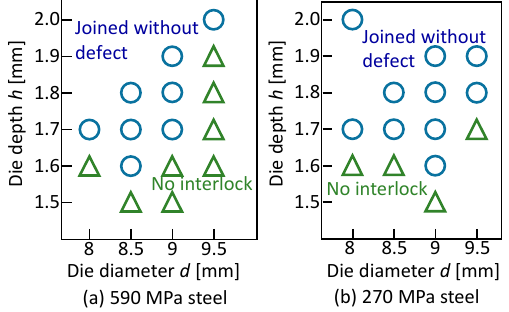
Figure 21. Joining ranges for ( a ) 590 MPa and ( b ) 270 MPa steel sheets and without adhesive.